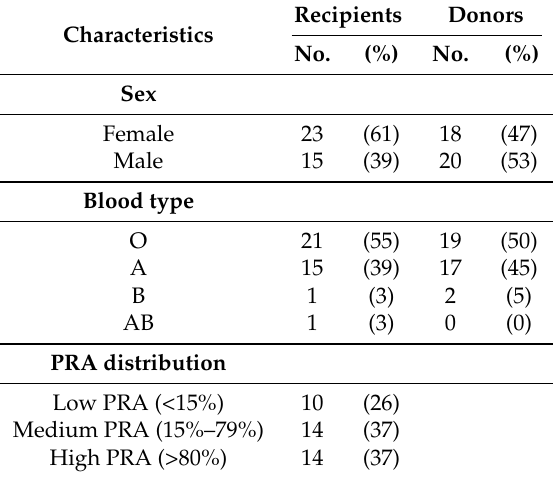
Table 1. Sex, blood type, and panel reactive antibody (PRA) distribution of recipients and donors.